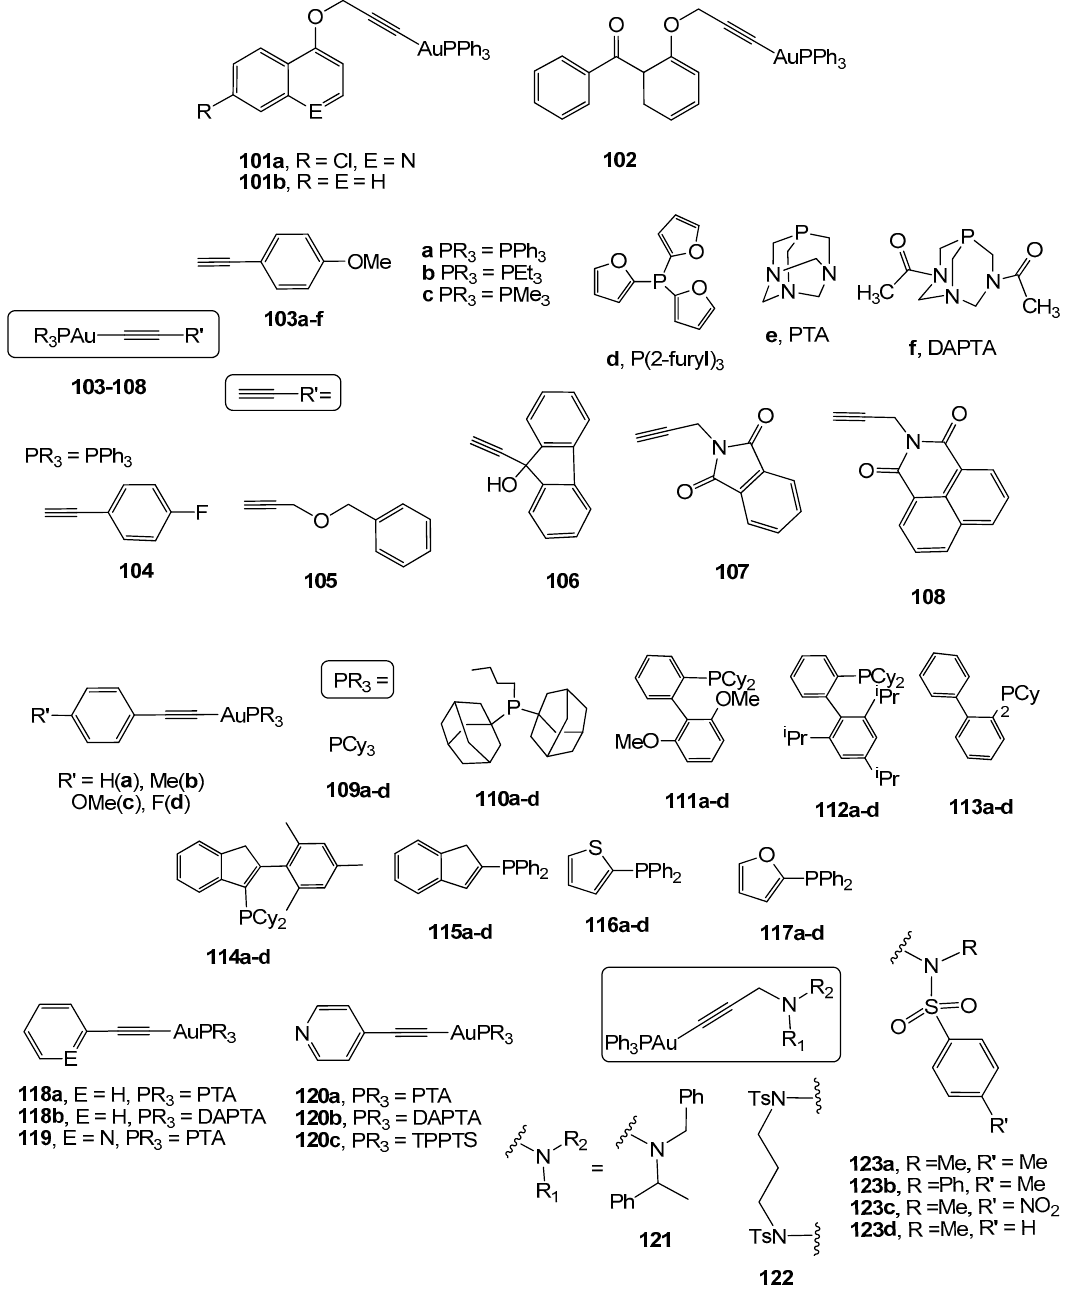
Figure 8. Alkynyl gold(I) derivatives.